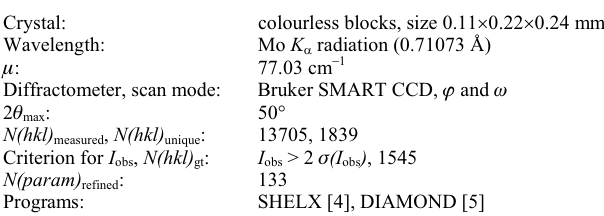
Table 1. Data collection and handling.